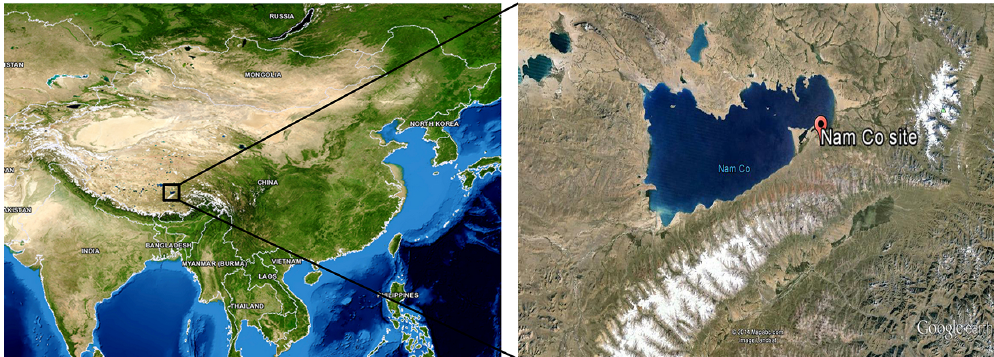
Figure 1. Nam Co site in the Tibetan Plateau,